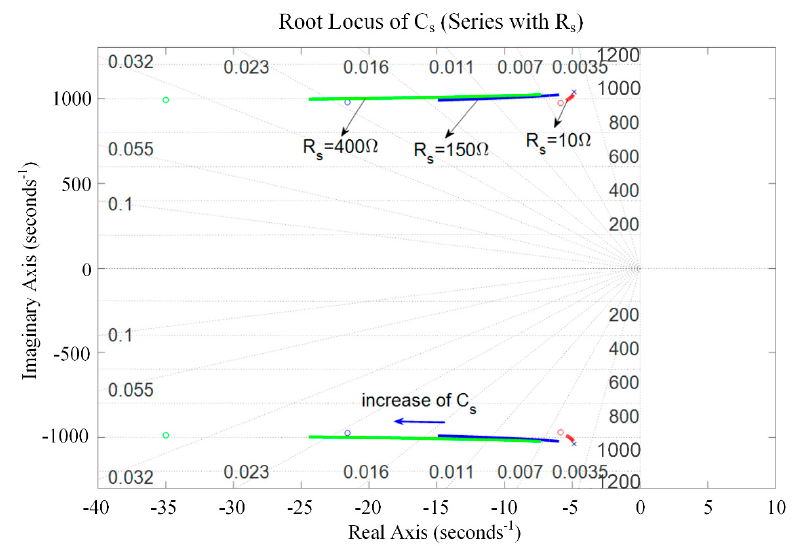
Figure 9. Root locus of the piezoelectric stack transducer with respect to C s for the negative capacitance in series with R s .